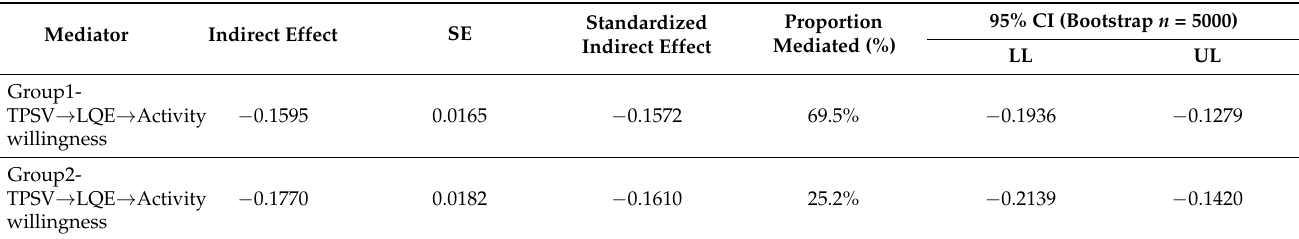
Table 12. The mediating role of LQE between TPS and activity willingness in two